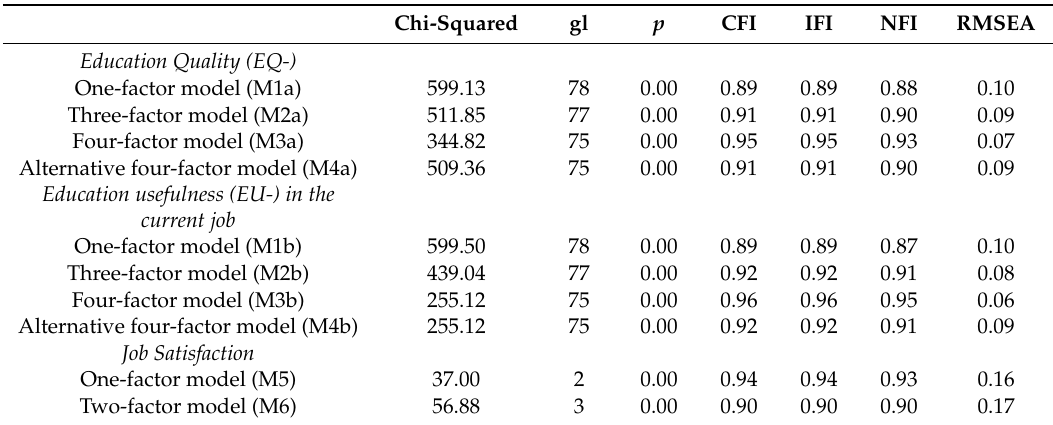
Table 1. Summary of confirmatory factor analyses: results of Education Quality (EQ-; models M1a–M4a) and Education Usefulness (EU-; Models